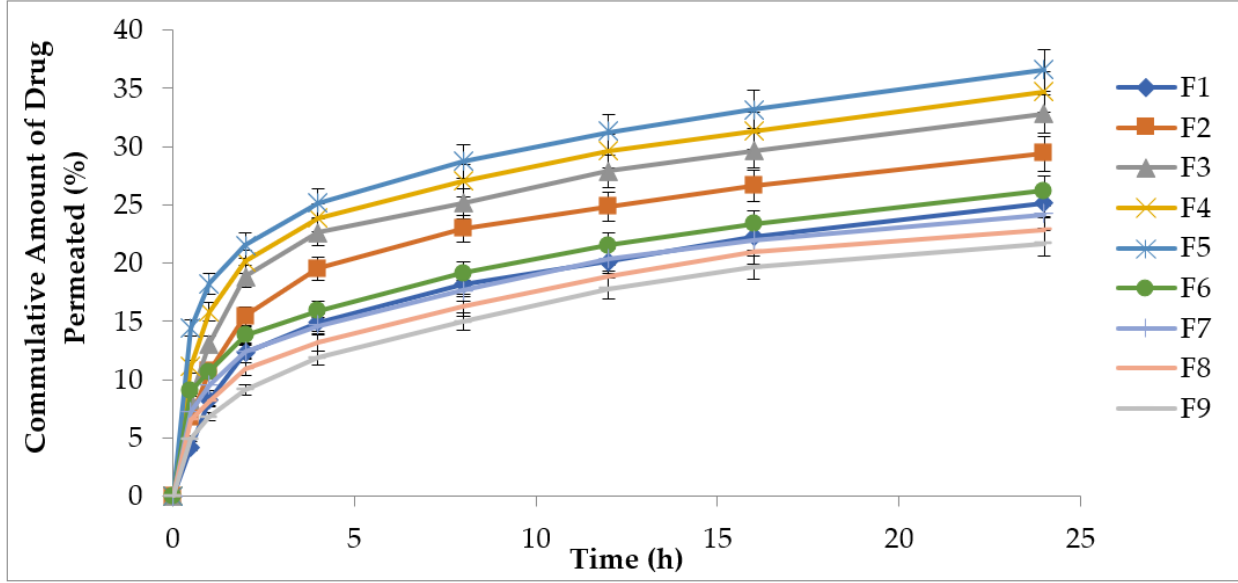
Figure 4. Percent cumulative amount of MTX permeated (F1–F9), Data were expressed as mean ± SD, n = 3. Significant compared to formalin (p < 0.05).